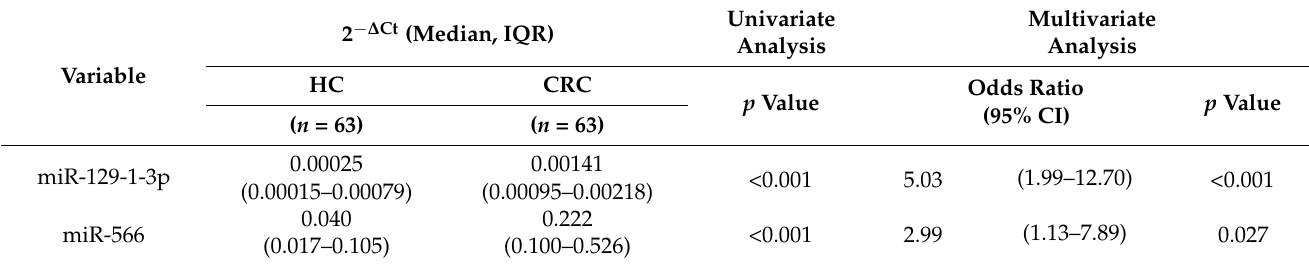
Table 3. Urinary miRNA biomarker in the validation